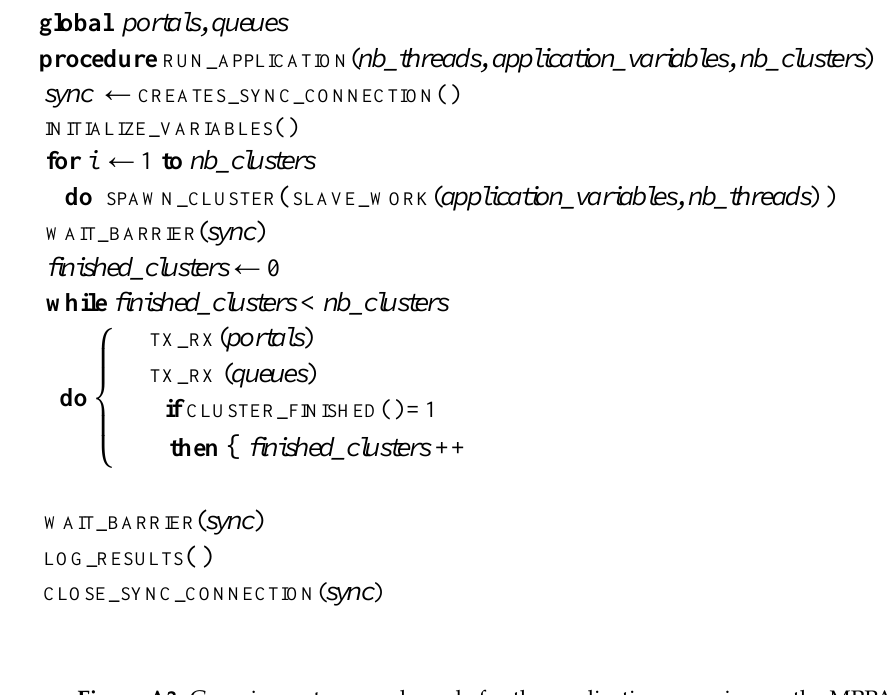
Figure A3. Generic master pseudo-code for the applications running on the MPPA.